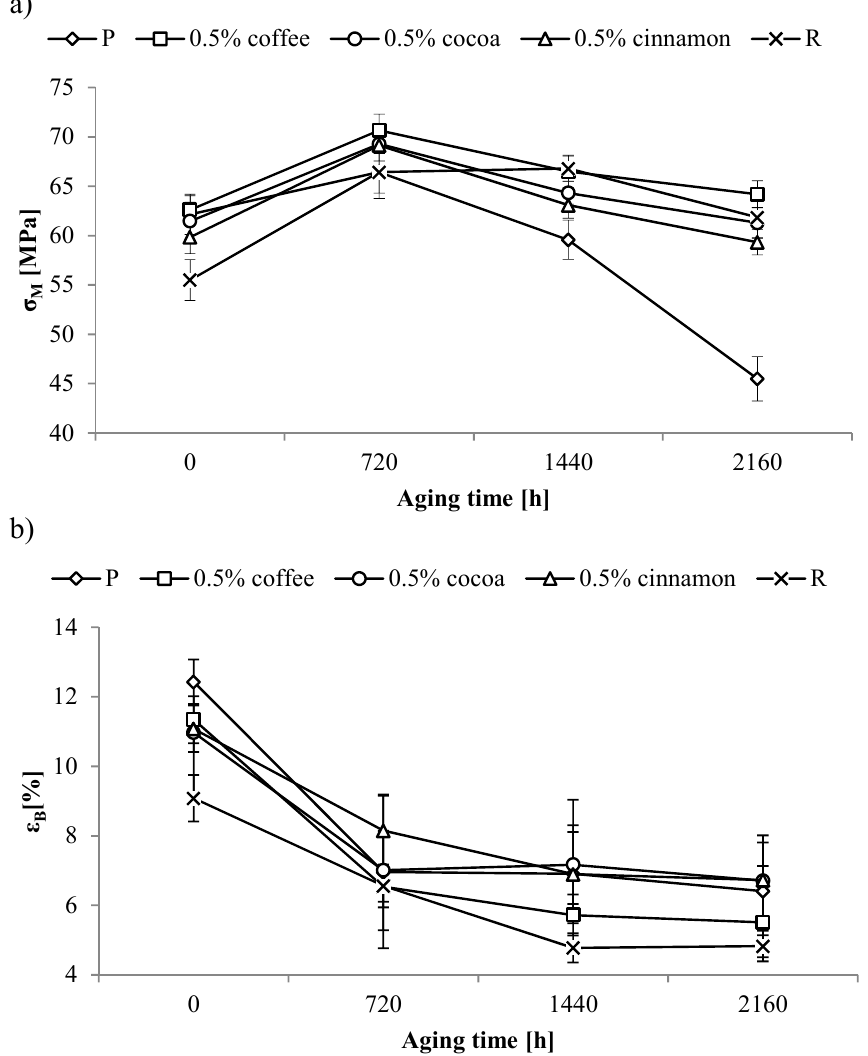
Figure 6. Changes in ( a ) tensile strength ( σ M ) and ( b ) tensile strain ( ε B ) of selected samples as a function of aging time.